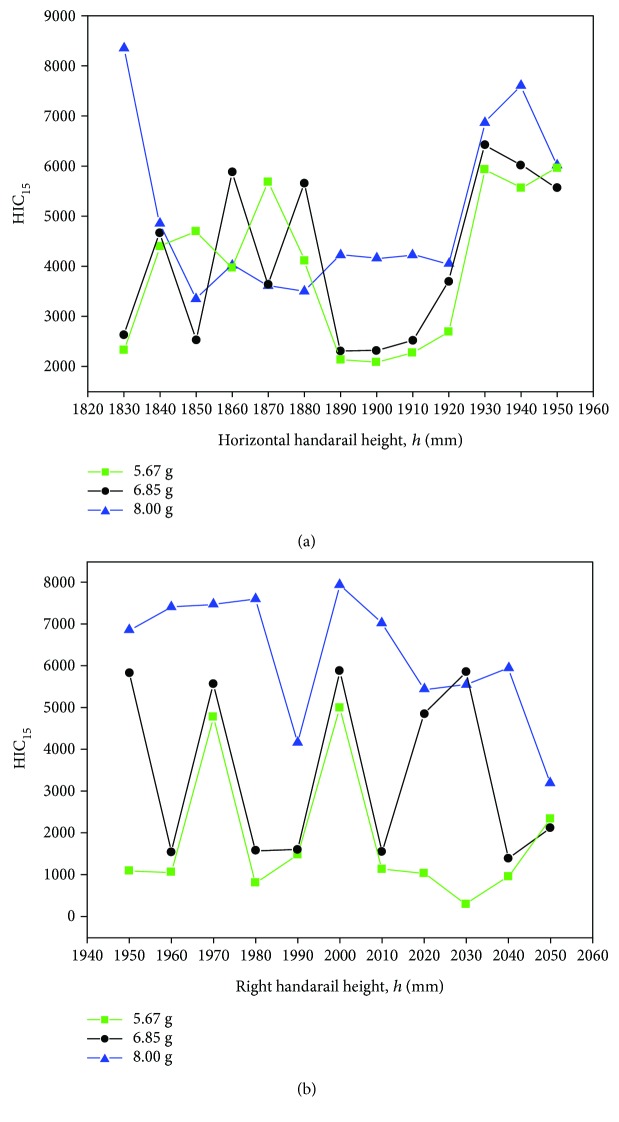
The relation of the height and HIC15 values in three acceleration conditions.